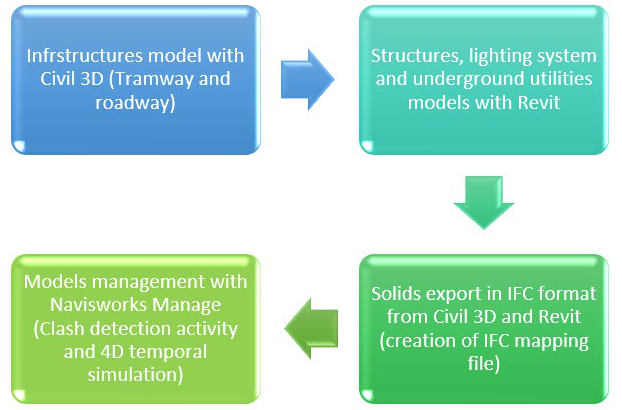
Figure 1. “Fiorini” tramway stop’s location along the Bologna’s Red Tramway Line. Figure 2 defines the analysis performed step-by-step. Figure 2 defines the analysis performed step-by-step.